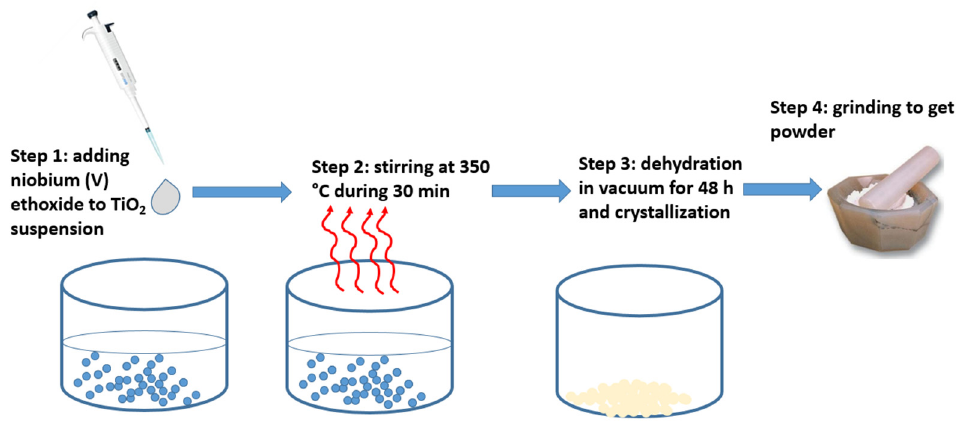
Figure 1. Schematic representation of different steps for the preparation of Nb(x)/TiO 2 nanocompo-